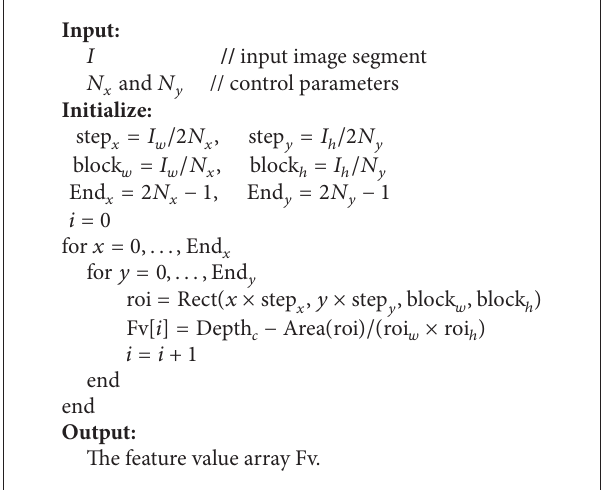
Algorithm 1: Proposed algorithm for feature extraction.